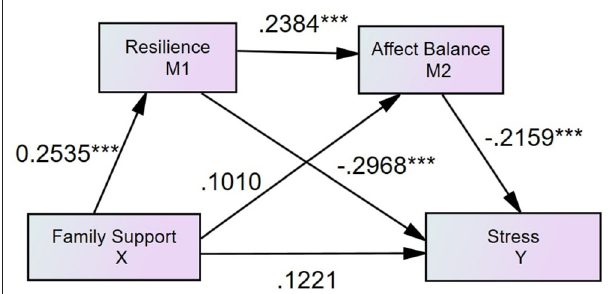
FIGURE 2 | Standardized structural model (family support, N = 339, R 2 = 0.2188). *** p <